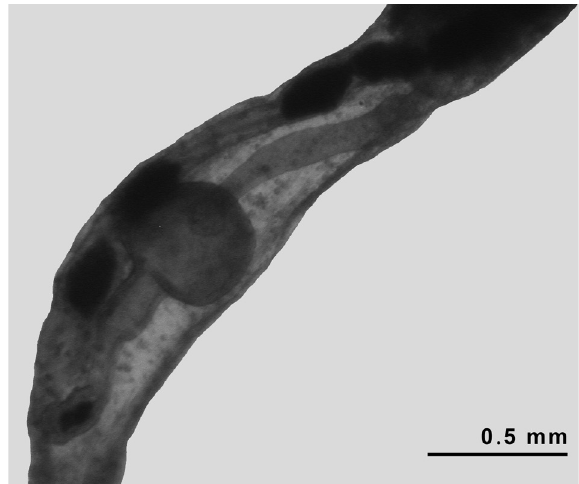
Figure 4. Abdomen of Synoicum molle showing the rounded smooth-walled